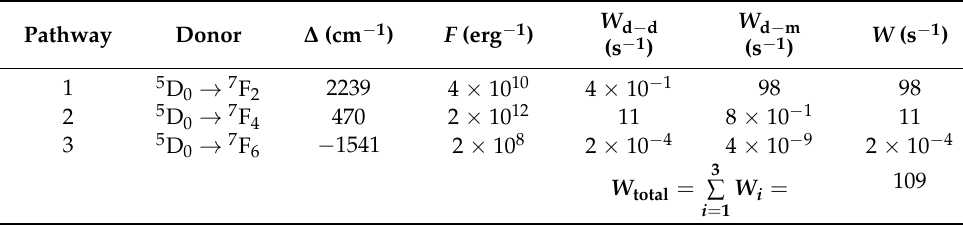
Table 2. Theoretical ET rates at room temperature for the [CrEuL 3 ] 6+ complex considering the acceptor transition as the barycenter of Cr(III) 2 E, 2 T 1 ← 4 A 2 transitions (envelope). R is the sum of W d − d and W d − m in the same pathway and the total rate W total is the sum over of all pathways rates. ways rates.